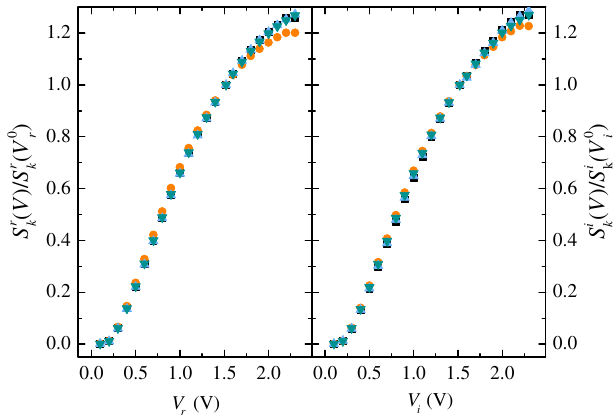
FIG. 12. dc response of the mixers. Left: Measurement of the ratio S r k ð V Þ =S r k ð V 0 r Þ , where S r k ð V Þ is the amplitude of the signal S r t Þ when the voltage V t Þ is set to V for k ¼ 1 (black squares), r ð k ð k ¼ 2 (orange circles), k ¼ 3 (blue upward triangles), and k ¼ 4 (green downward triangles). Right: Measurement of the ratio S i V Þ =S i V 0 S i V Þ is the amplitude of the signal S i i Þ , where k ð k ð k ð when the voltage V i ð t Þ is set to V (same color code). We choose k ¼ 3 to determine f V Þ and f V Þ . r ð i ð